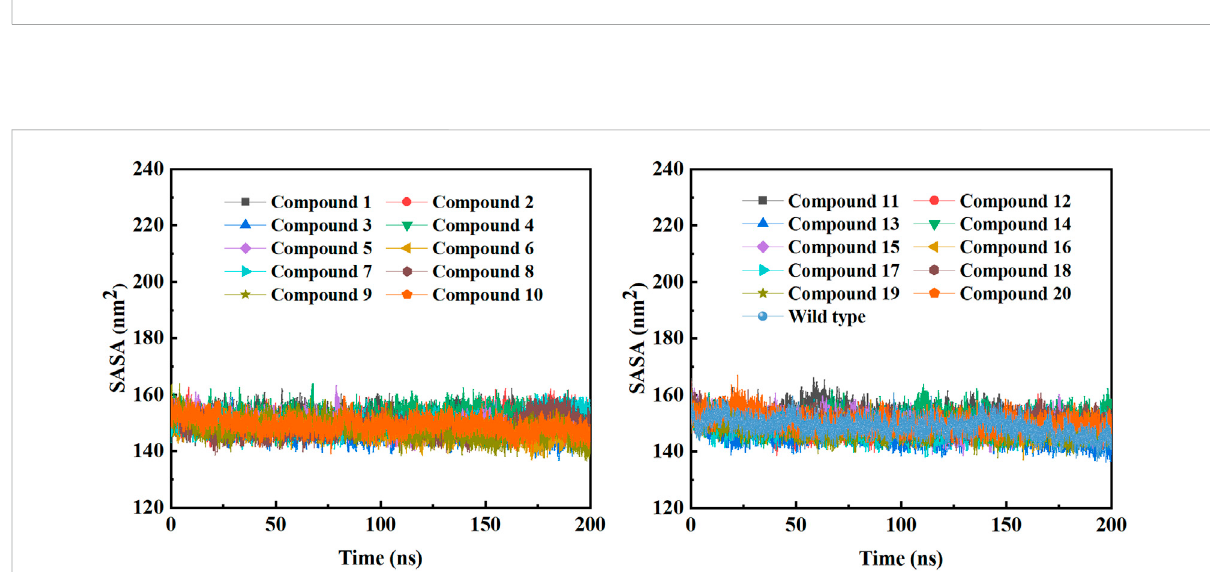
FIGURE 8 The SASA plots of COVID-19 M pro in a MD simulation system containing different ligands or wild M pro